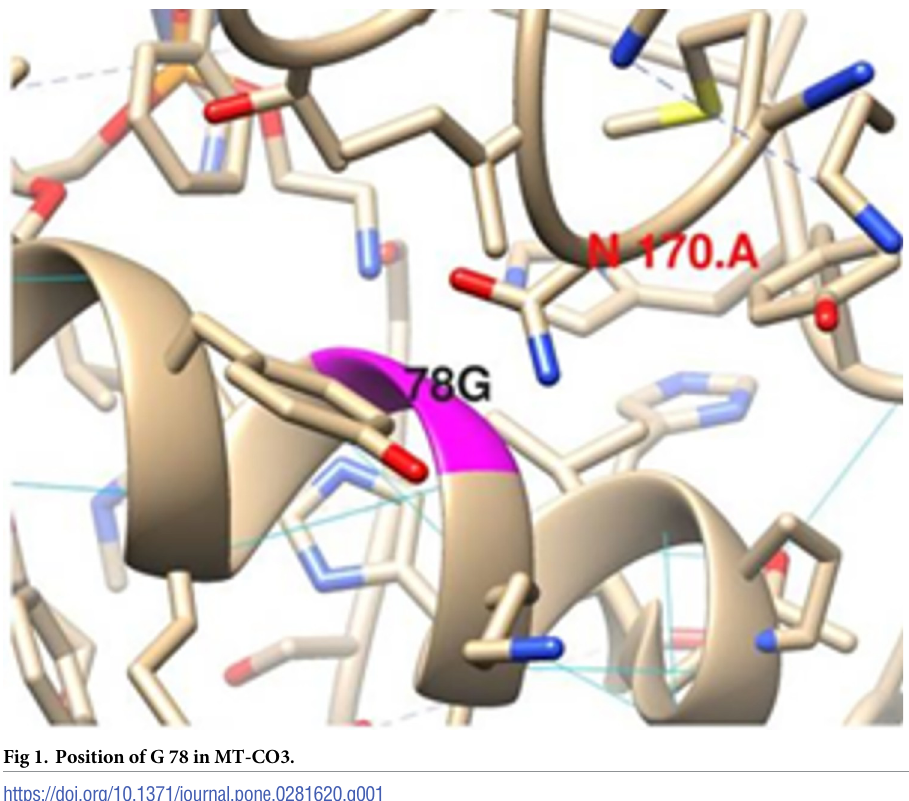
Fig 1. Position of G 78 in MT-CO3.